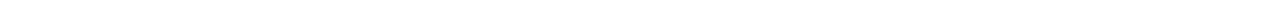
Fig. 6 mTOR is activated and interacts with the IKK complex upon genotoxic treatment. a Immunoblot analysis of ATM, TAK1, Akt and mTOR activation at different time points after bleomycin treatment of PSC27 cells. Total proteins of these factors and GAPDH were loading controls. b Representative IF images for mTOR phosphorylation (S2448) in PSC27 cells treated by bleomycin with or without RAD001 (50 nM) (blue, DAPI; red, γ H2AX; green, p-mTOR). Cells were stained 7d after bleomycin treatment. Scale bars, 15 μ m. c Immunoblot analysis of mTOR activation and downstream substrate (S6K1/4E-BP1) phosphorylation in cells treated by bleomycin with or without RAD001. Lysates were collected 7d after initiation of treatment, the same time point for sample acquirement of following assays. d DNA synthesis assay by BrdU incorporation for cells treated in different conditions, with positive ratios displayed in percentage. Right, representative images (green, BrdU; blue, DAPI). Scale bars, 15 μ m. Data analyzed by Student ’ s t -test. e Stromal cells were stained in culture for SA- β -Gal, with results presented as positivity ratio. Right, representative images. Scale bars, 20 μ m. Data analyzed by Student ’ s t -test. f Immunoblot examination of NF- κ B pathway in stromal cells treated by bleomycin, with or without RAD001. Cell lysates were fractionated into cytoplasmic and nuclear extracts for comparative analysis. g Cells were transfected with a reporter construct that encodes NF- κ B binding sites in the promoter region of a luciferase transgene. Signals were normalized as readings of fi re fl y/renilla ratio. Data analyzed by Student ’ s t -test. h Co-IP assay to determine the interaction between mTOR and IKK complex. PSC27 cells were treated with bleomycin, and cell lysates were collected 7d later for IP analysis with anti-mTOR or anti- IKK α . IgG, control. Data in all bar plots are shown as mean± SD and representative of 3 biological replicates. * P < 0.05, ** P < 0.01, *** P < 0.001, ^ P >